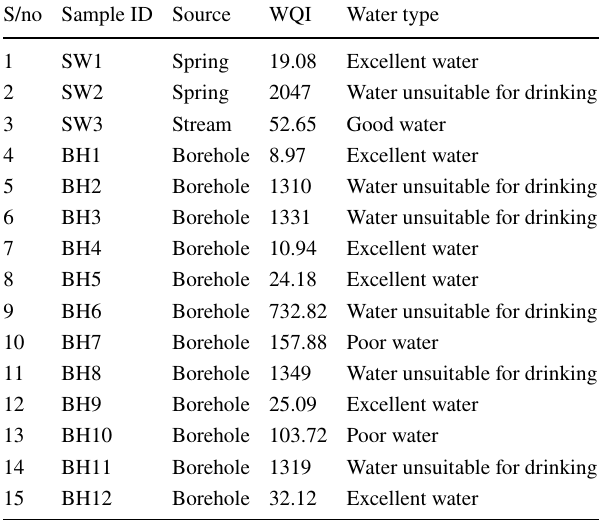
Table 7 Relative weight of water quality parameters Parameter